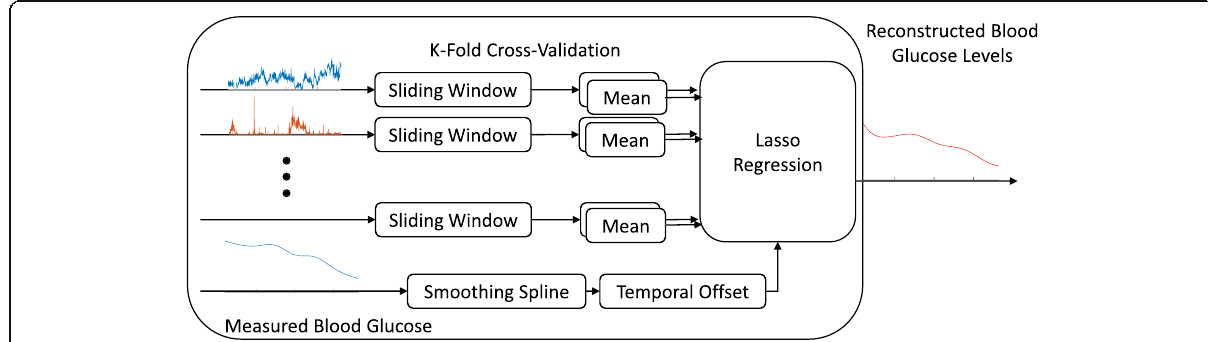
Fig. 3 Decoding Algorithm and illustrative example. Schematic Diagram of the decoder used to regress the CAP event rates to the blood glucose concentration. The means of 20s, non-overlapping sliding windows over the event rates for the previous 4min were used as features to the lasso regression model with a regularization factor of 1. The inputs were regressed against a non-time-shifted version of the smoothing spline fit to the measurements of the blood glucose concentration. Leave-one-out cross-validation with 12 folds was used to train 12 separate regression models, and the out-of-sample data was evaluated for each model to reconstruct a piecewise response